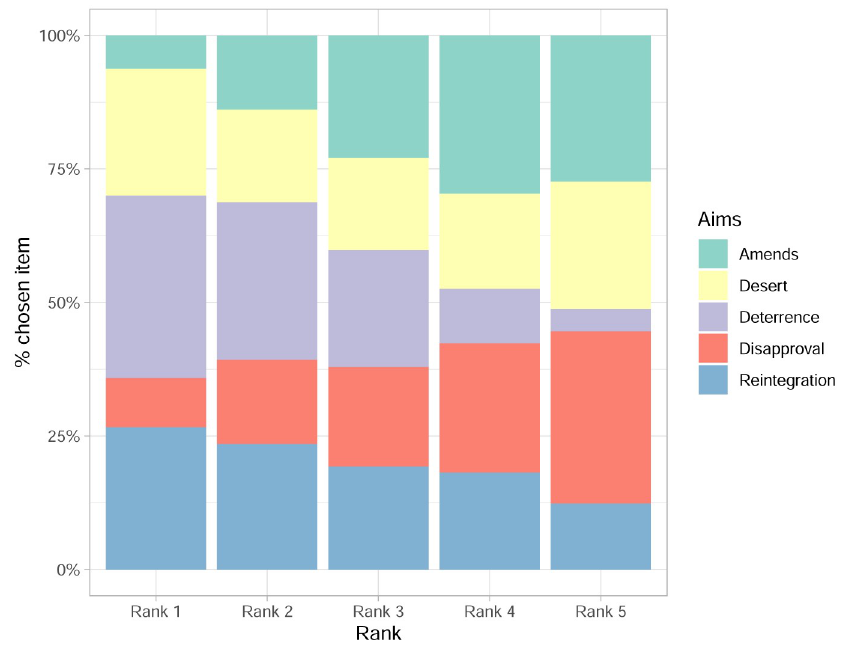
Fig 3. Ranking aims of